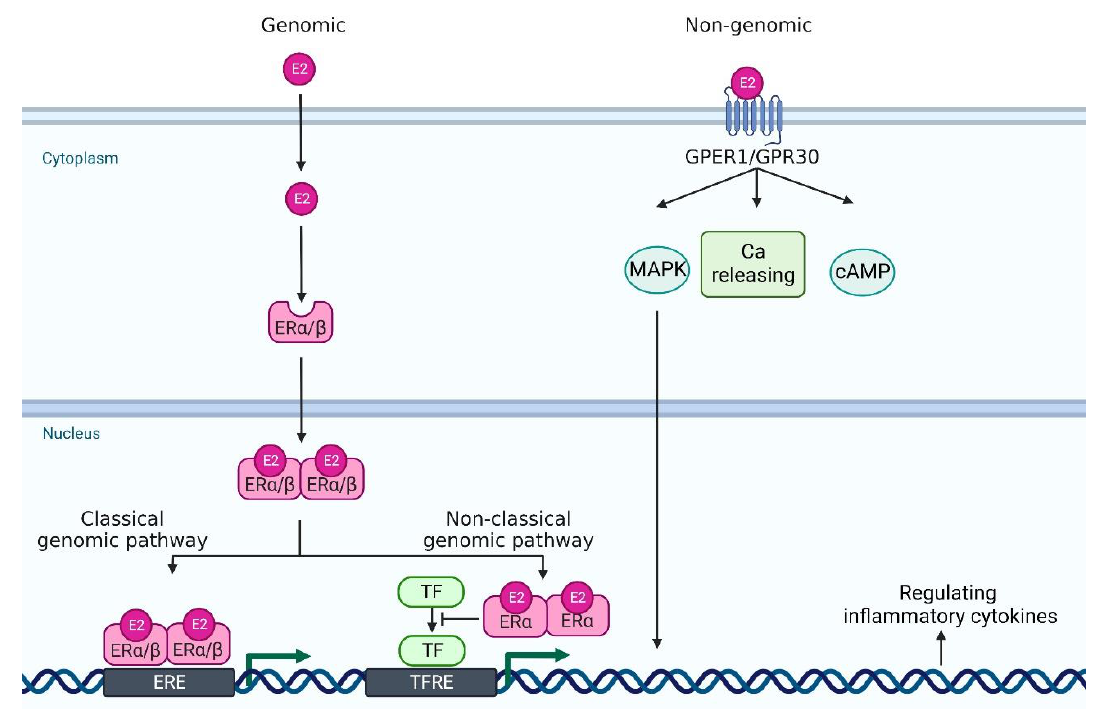
Figure 1. A scheme of estrogen receptors and the intracellular signaling pathway. In genomic pathway, 17 β -estradiol (E2) binds to estrogen receptor α and estrogen receptor β in the cytoplasm. It forms dimer and translocates to the nucleus. Then, they bind to estrogen receptor element (ERE) and activate the transcription of downstream genes (classical genomic pathway). Or, they interact with other transcription factor (TF)s, such as NF- κ B, specificity protein 1 (SP1), activator protein-1 (AP-1), and CCAAT/enhancer binding protein β (C/EBP β ), and prevent their binding to the transcription factor regulatory element (TFRE) (non-classical genomic pathway), leading to the regulation of their target gene expression. In non-genomic pathway, E2 binds to G protein-coupled estrogen receptor 1 (GPER1) and it regulates mitogen-activated protein kinase (MAPK), calcium (Ca) release, and cyclic adenosine monophosphate (cAMP). Created with Biorender.com.